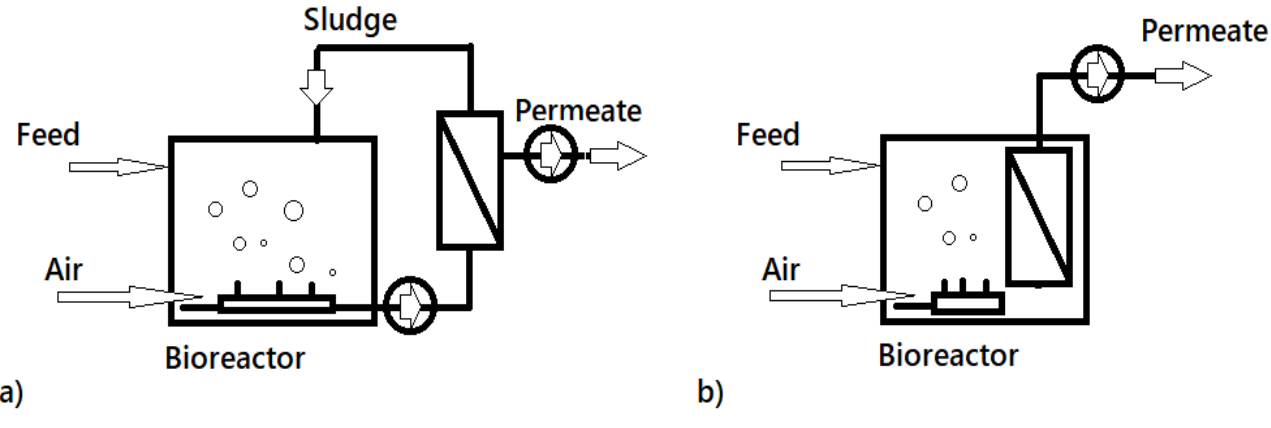
Figure 9. MBR configurations: ( a ) Side-stream and ( b ) submerged.